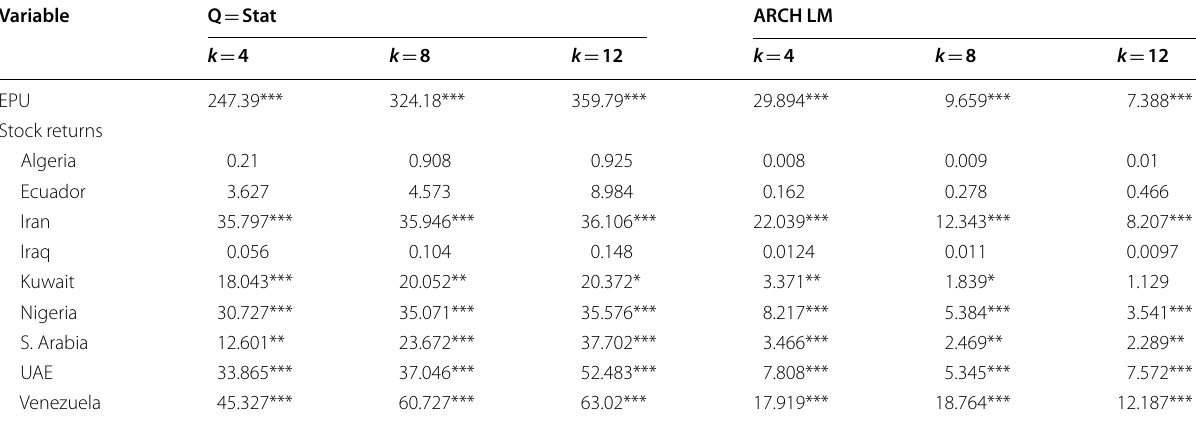
Table 2 Serial correlation and conditional Heteroskedasticity tests results